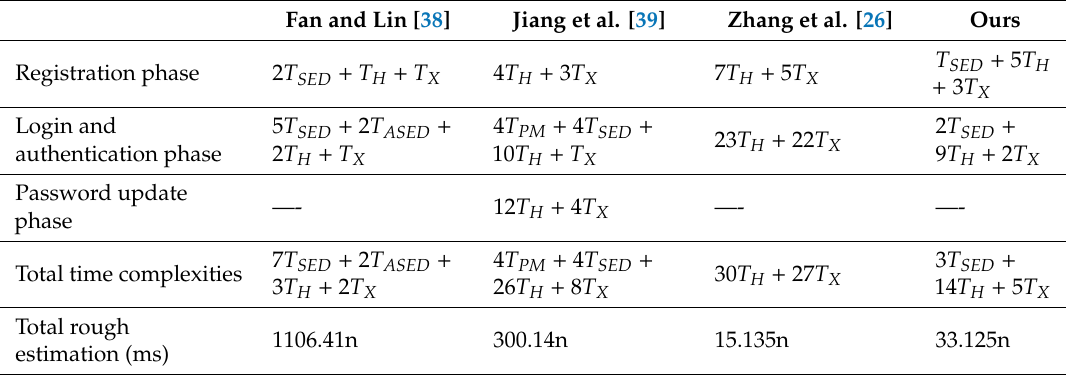
Table 3. Comparison of computational